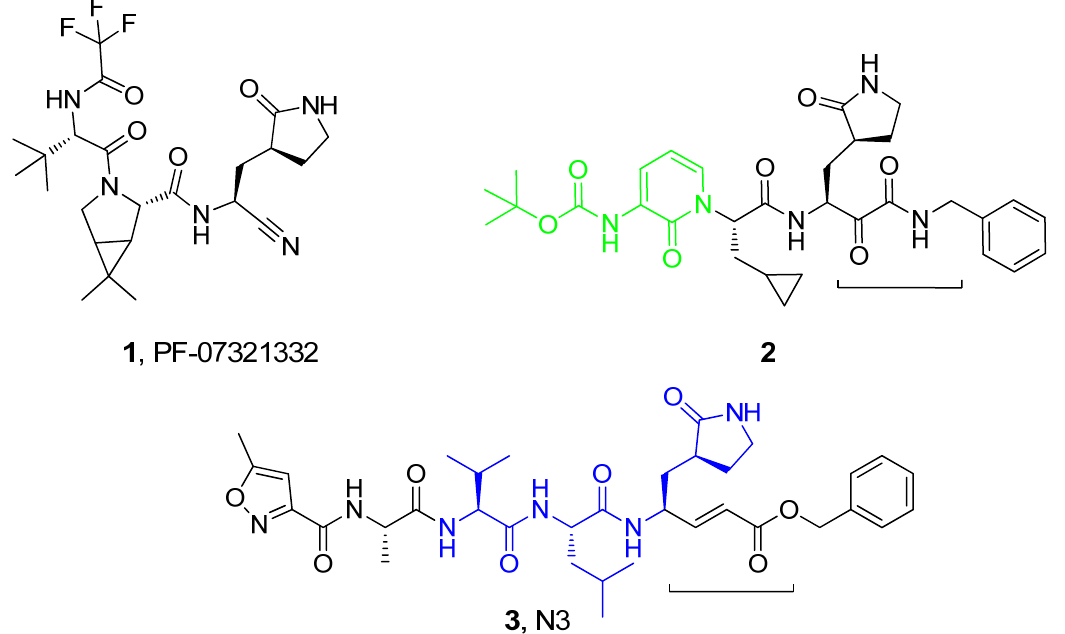
Figure 1. Chemical structures of reported SARS-CoV-2 M pro inhibitors ( 1 – 3 ) showing different electrophilic warheads.